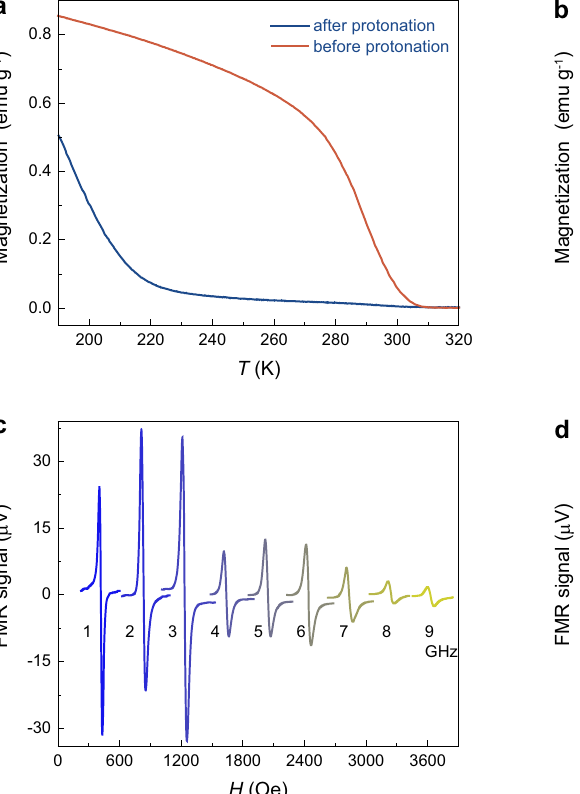
c The FMR spectrameasured atroomtemperatureand RF conditions for VCr-PBA. d Room-temperature FMR spectra under 1GHz for VCr-PBA at different protona- tion levels. Source data are provided as a Source Data fi